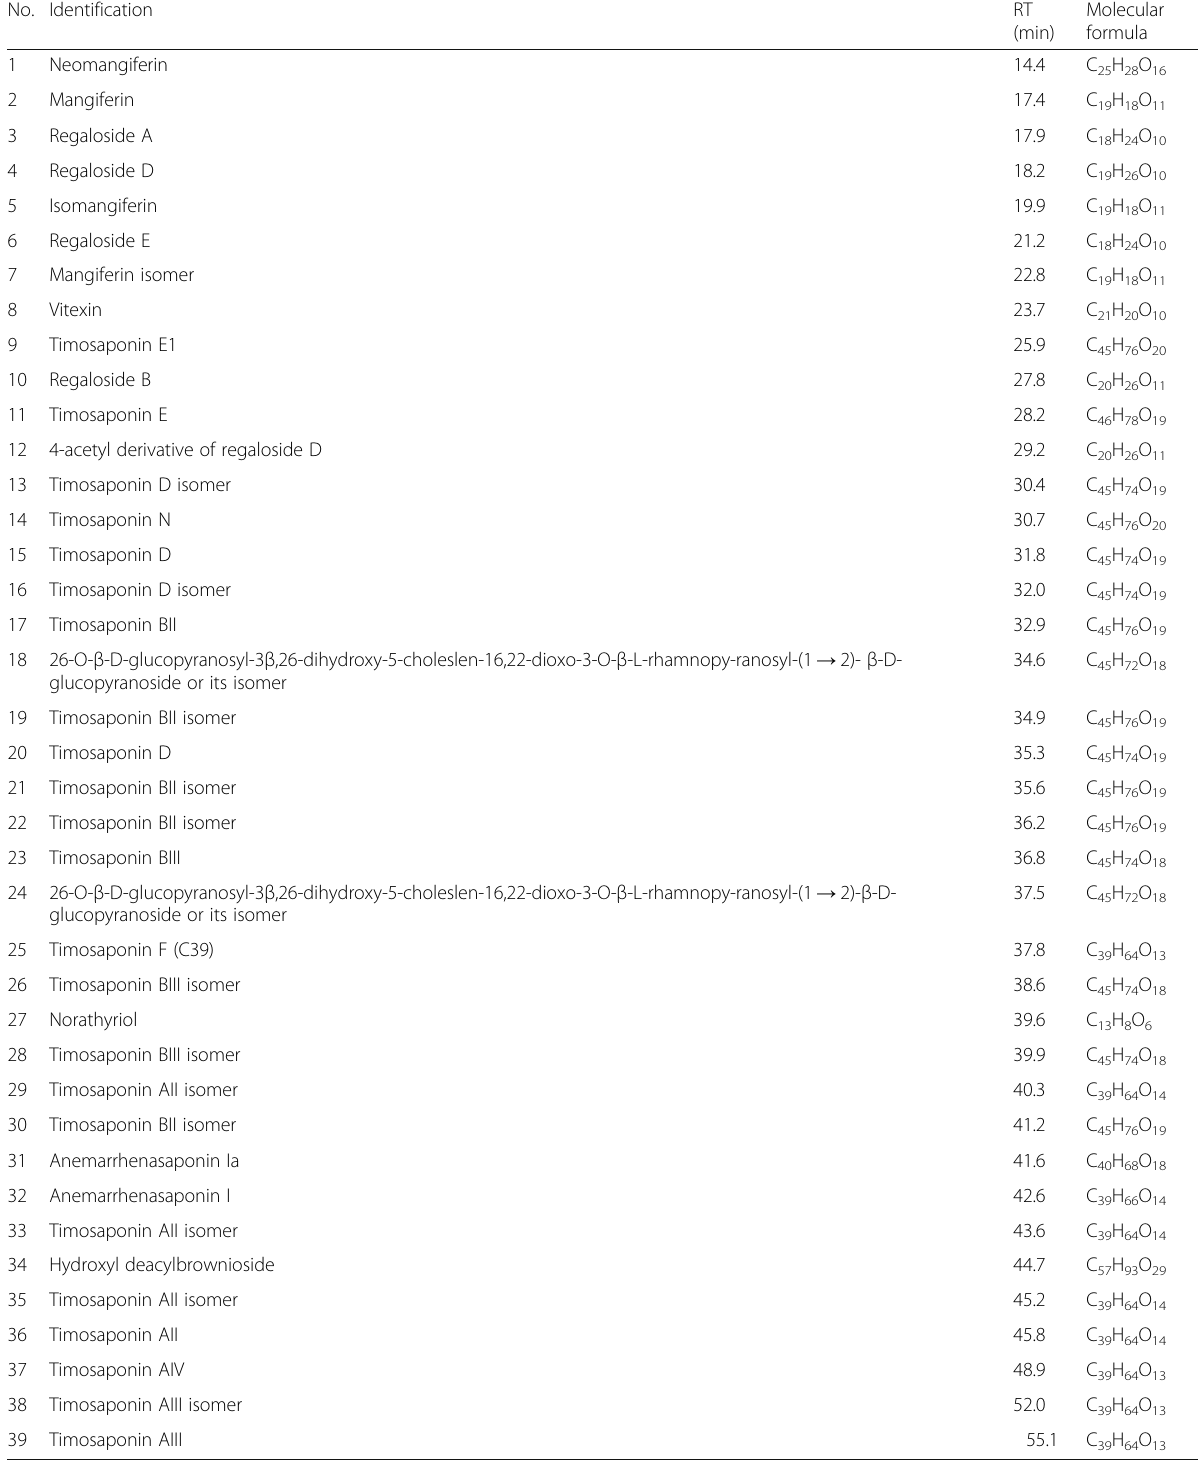
Table 2 The components of BZ formula identified by